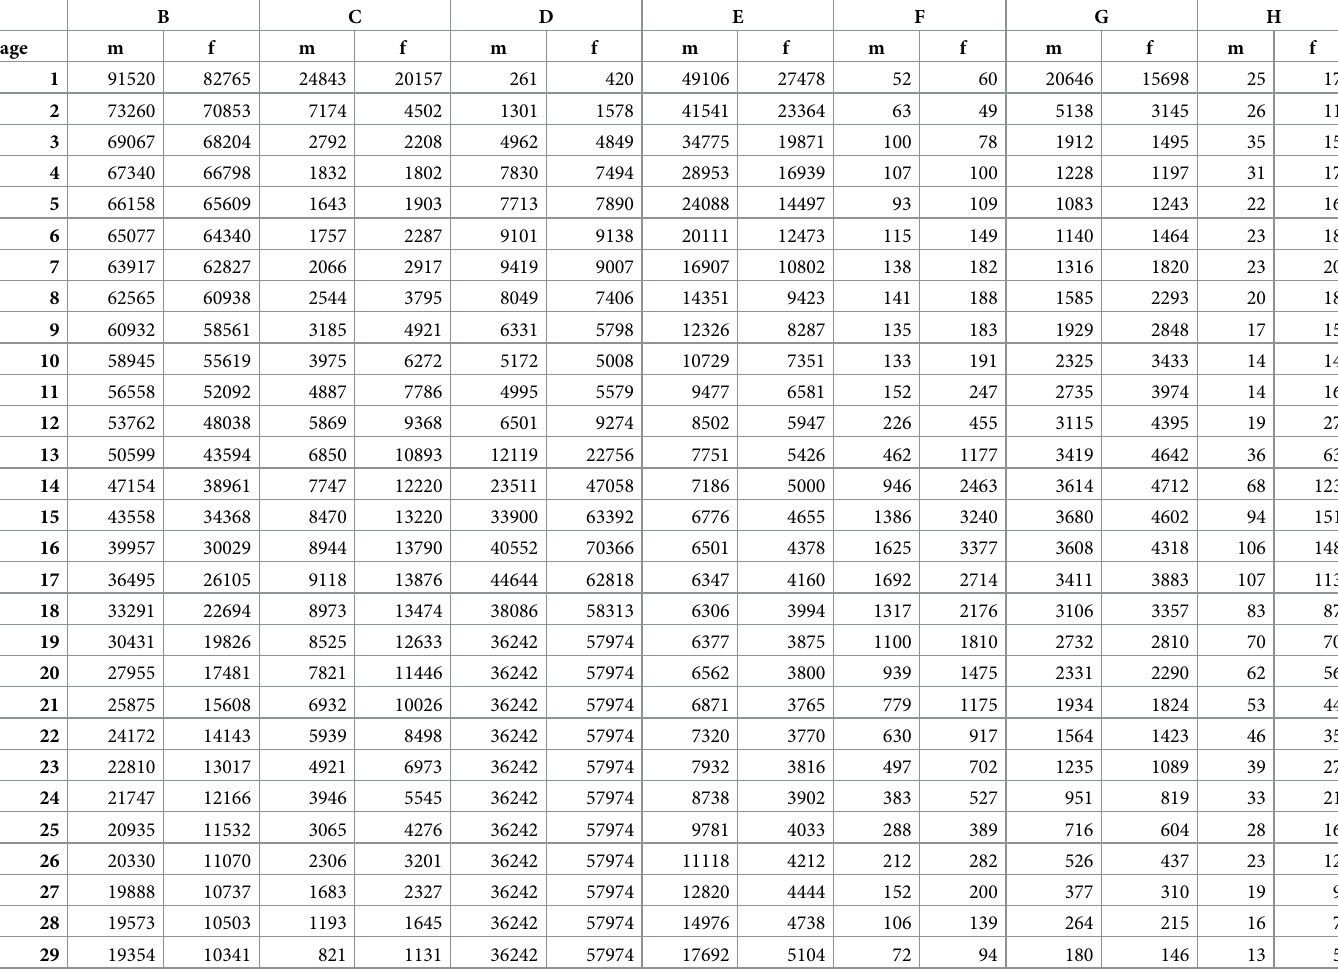
Table 1. Model predictions by age and sex. Prevalent cases per 100,000 cases (B), events per 100,000 person-years (C,F,G,H) and probability x 100,000 (D,E). B: EBV naive, C: seroconversion hazard rate, D: attack rate, E: fraction of hospitalized IM cases, F: IM population hazard rate, G: seroconversion population hazard rate and H: hospitalized IM population hazard rate. C-H are averages within the age group, B is the maximum within the age group, i.e. who were EBV-na ï ve at exact age 1,2, ... Refer to Fig 1 and methods for further